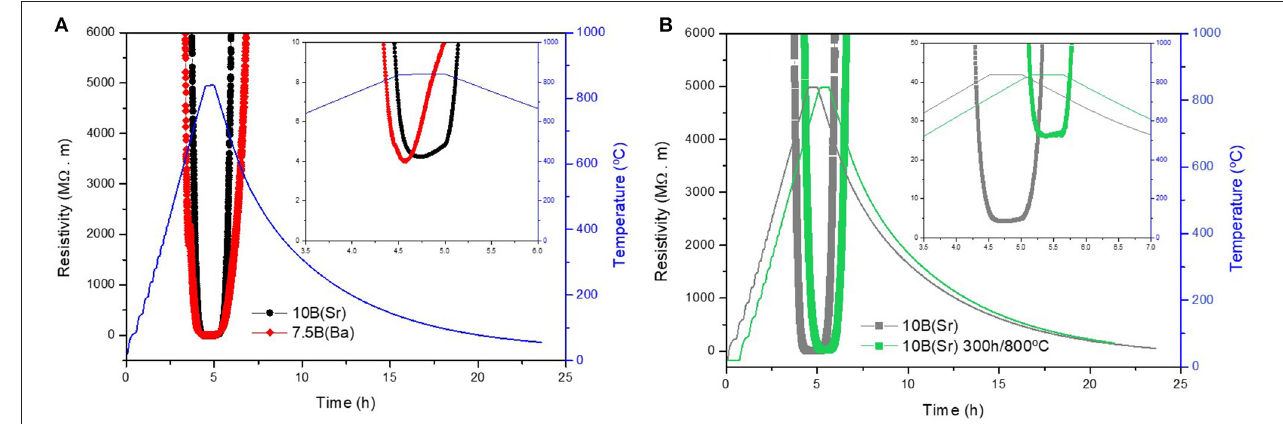
FIGURE 3 | (A) Electrical resistance of the joints with compositions 7.5B(Ba) and 10B(Sr) after the sealing and at high temperature. (B) Electrical resistance at high temperature of the joints with composition 10B(Sr) after sealing and after 300h of thermal treatment at 800 ◦ C.